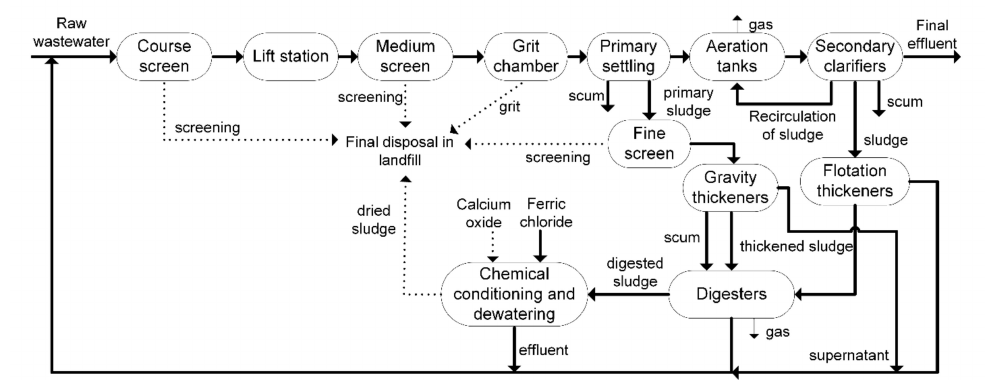
Figure 3. Diagram of the wastewater treatment plant ABC with all the treatment processes and flows. Notes: Wide arrows: Liquid state; dashed arrows: Solid state; thin arrows: Gaseous state. On the